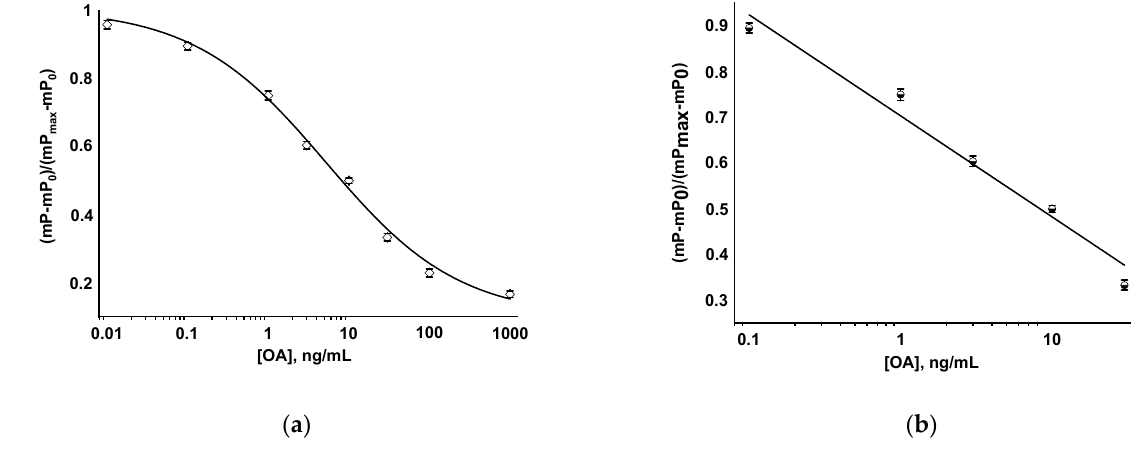
Figure 6. Calibration curve of OA in FPIA ( a ) and its linear range ( b ). Using the developed FPIA, OA concentration was determined with the LOD of 0.08 ng/mL (0.1 nM), and the working range of detectable concentrations was 0.4–72.5 ng/mL (0.5–90 nM). The duration of measurements was 5 min.